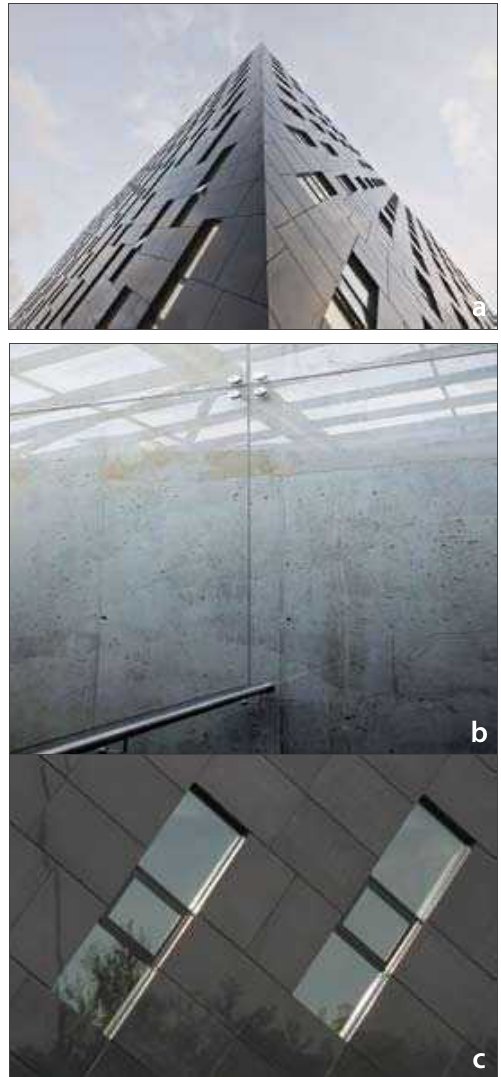
Fig. 16. Prosecutor's building details (a, b, c), Vilnius. arch. k. Lupeikis,